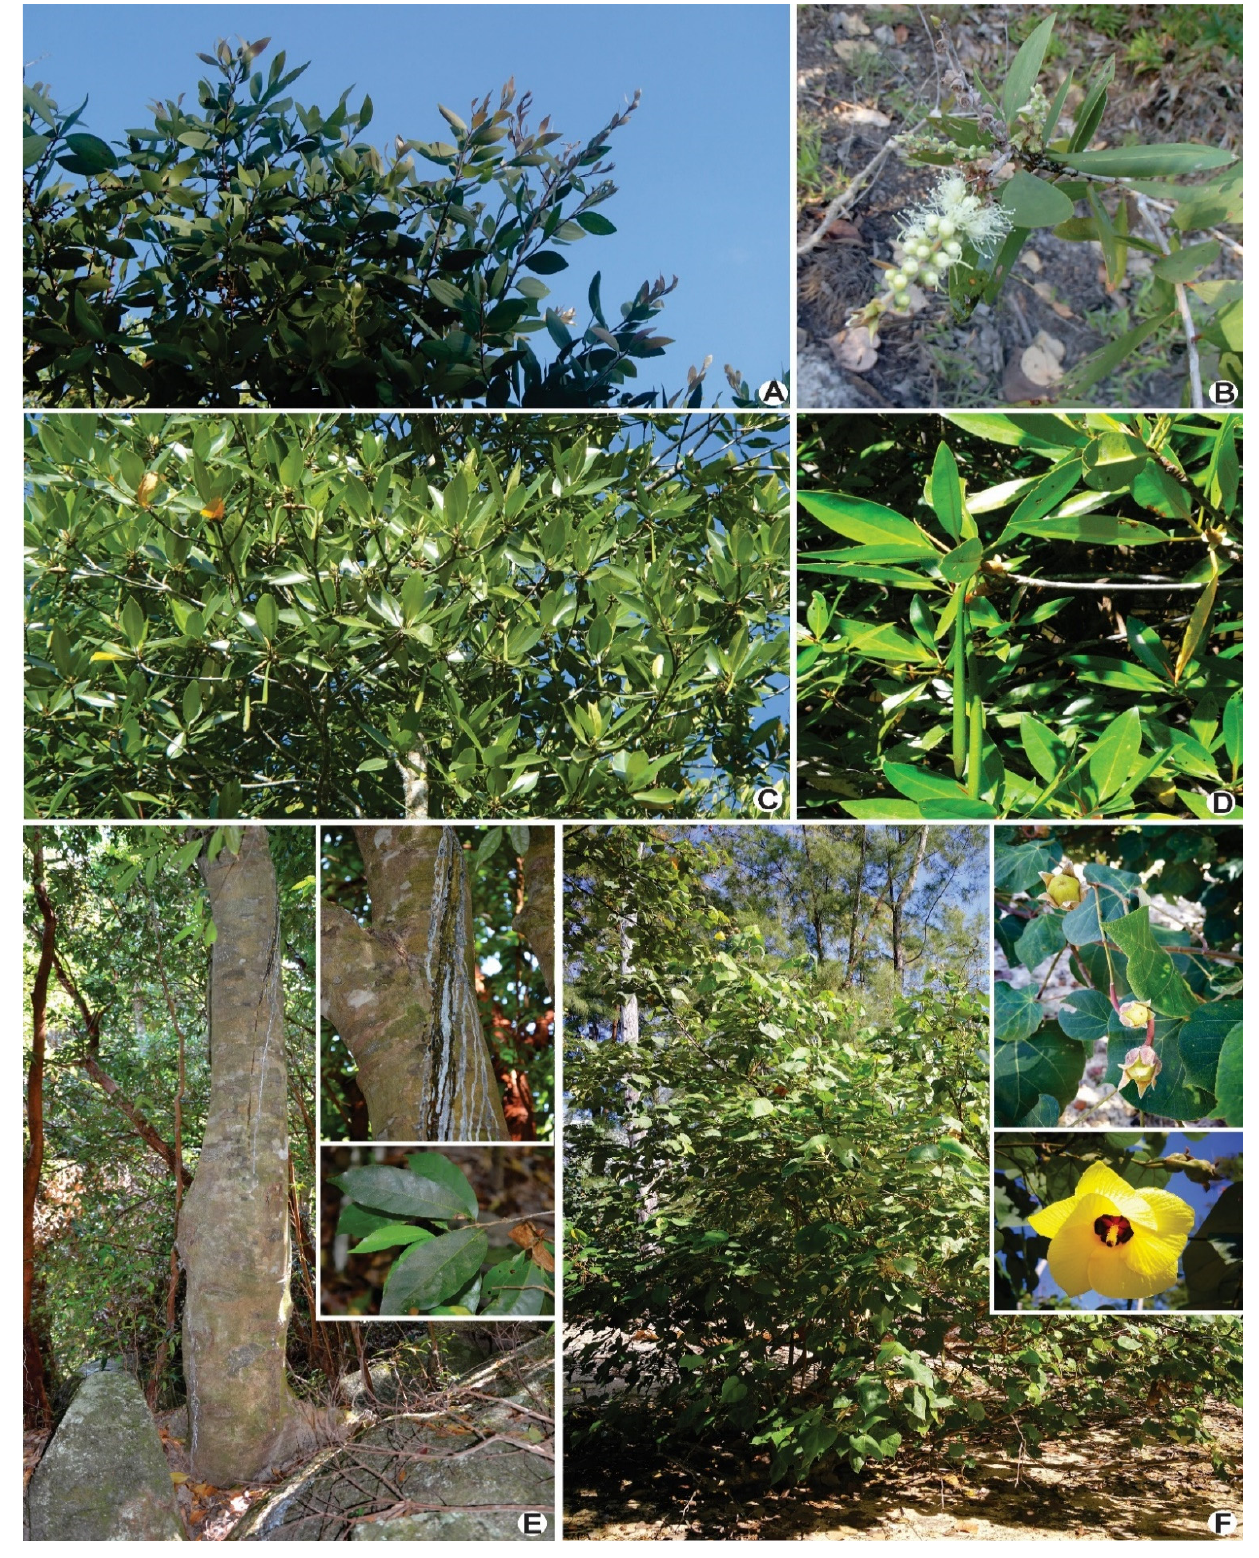
Figure 3. Some of the plants found in the study areas. ( A ) Top canopy of Melaleuca cajuputi ; ( B ) leaves and inflorescence of Melaleuca cajuputi; ( C ) top canopy of Rhizophora apiculata; ( D ) leaves and propagules of Rhizophora apiculata; ( E ) bark of Vatica sp. (inset top: white resin, bottom: leaf arrangement); ( F ) habitat of Talipariti tiliaceus (inset top: fruit, bottom: flower).